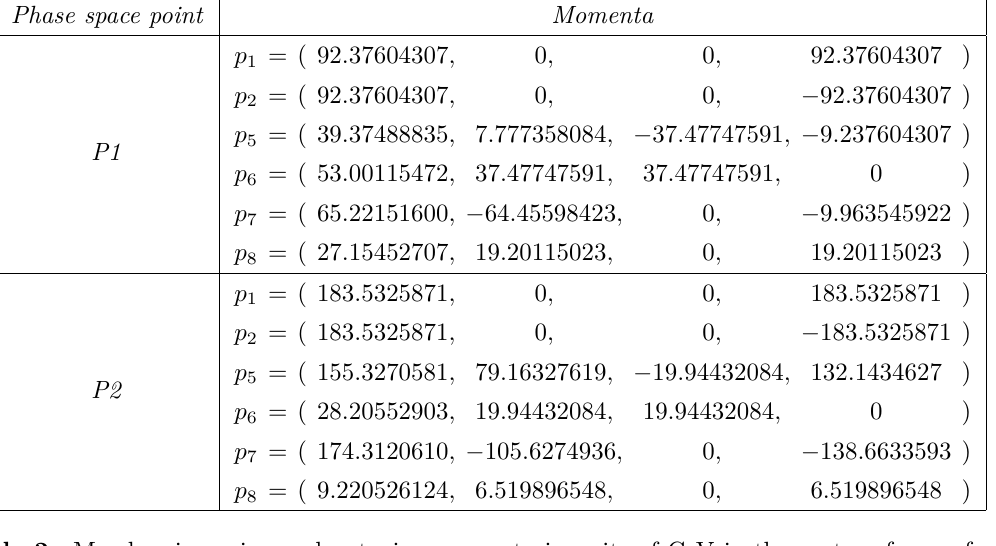
Table 2. Massless incoming and outgoing momenta in units of GeV in the centre of mass frame for the phase space points defined in eq. (5.2) and eq. (5.3). A (1) | (cid:15) =0